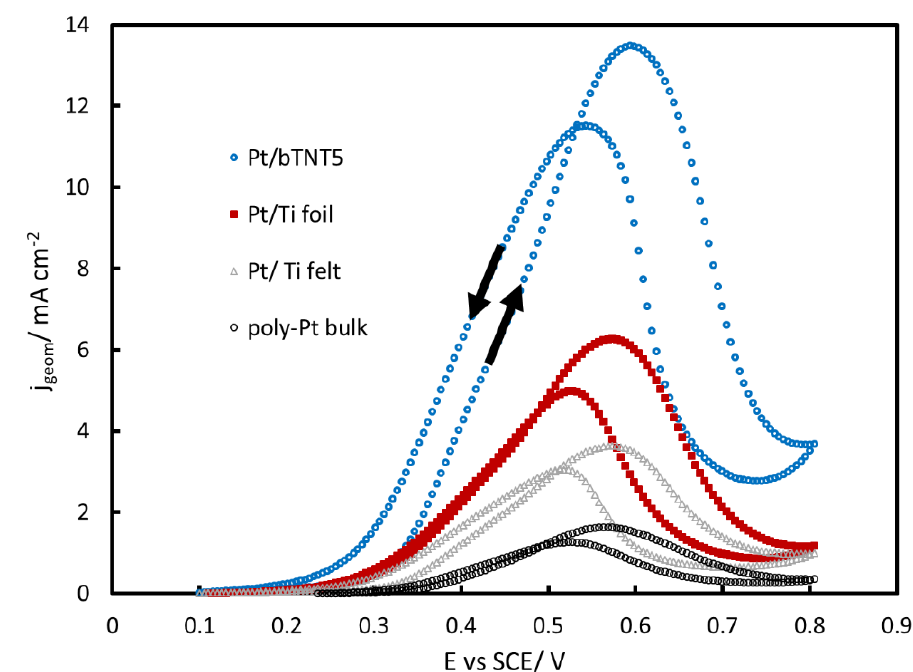
Figure 5. Voltammograms of Pt/bTNT5, Pt/Ti foil, Pt/Ti felt and polycrystalline bulk Pt in a N 2 -deaerated solution of 0.1 M HClO 4 + 0.5 M MeOH, at a low scan rate of 5 mV s −1 , scanned between +0.1 – +0.8 V SCE (forward and backward scans). The current is normalized per substrate geometric area in cm 2 .